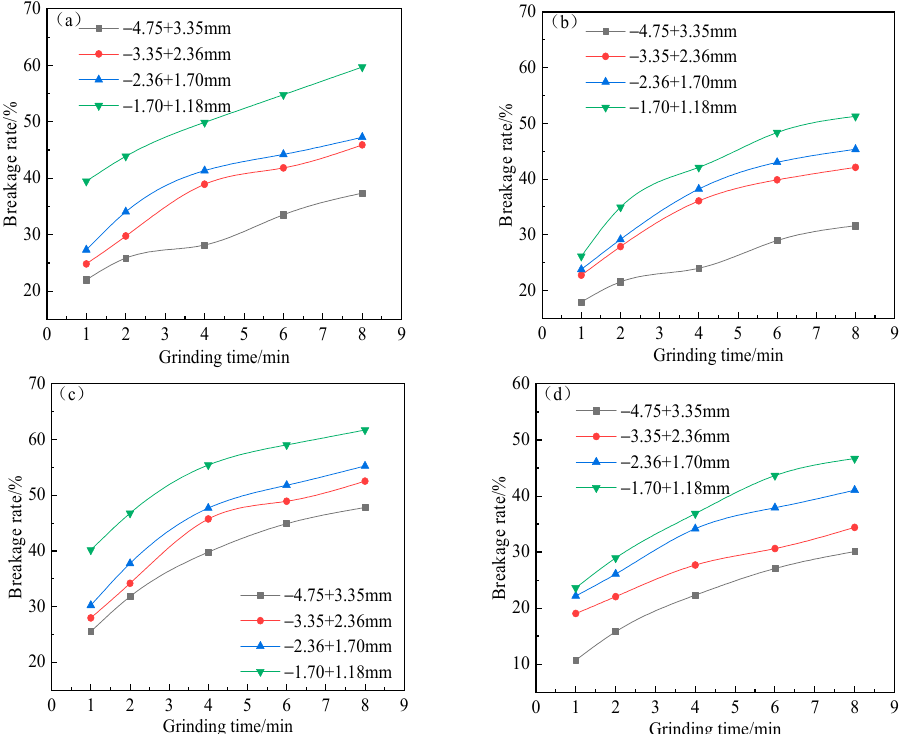
Figure 3. The relationship between breakage rate of materials and grinding time at different feed sizes ( a ) Ore, ( b ) Pyrrhotite, ( c ) Sphalerite, ( d ) Quartz. sizes ( a ) Ore, ( b ) Pyrrhotite, ( c ) Sphalerite, ( d )